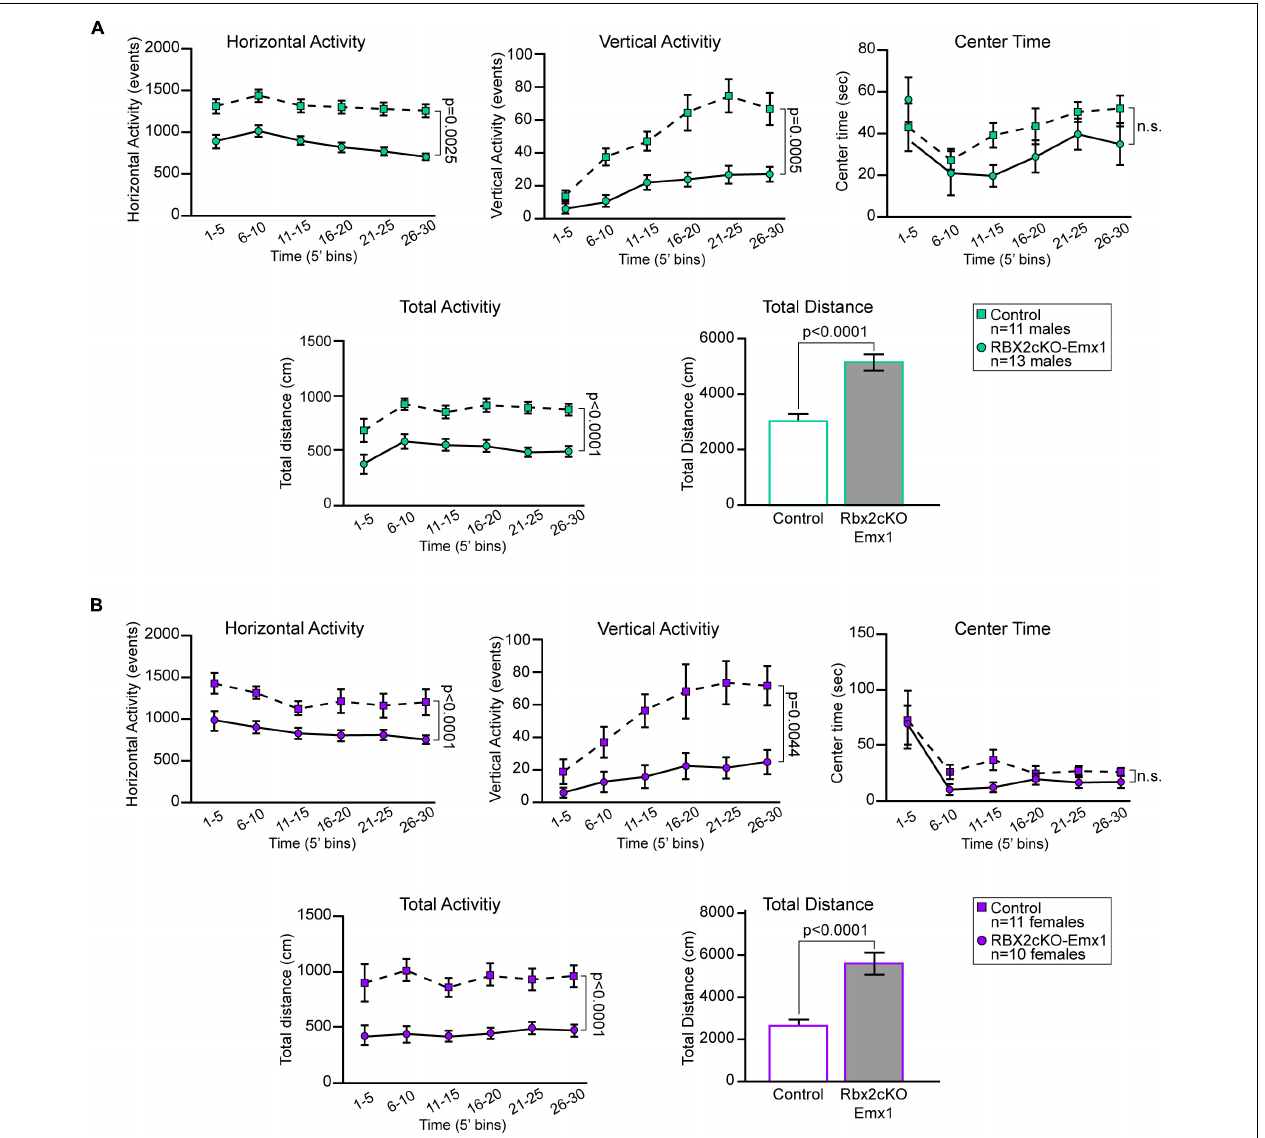
FIGURE 4 | In an open field test, both RBX2 mutant male (A) and female (B) mice (P75) showed increased horizontal (distance moved) and vertical (rearing) activity as well as higher total activity and distance moved in 30 min in comparison to control mice. On the contrary, both male and female RBX2cKO-Emx1 mice did not show changes in the amount of time spent at the center of the field. Mean ± SEM. Statistics, two-way ANOVA for all quantifications, except unpaired Student’s t -test for total distance